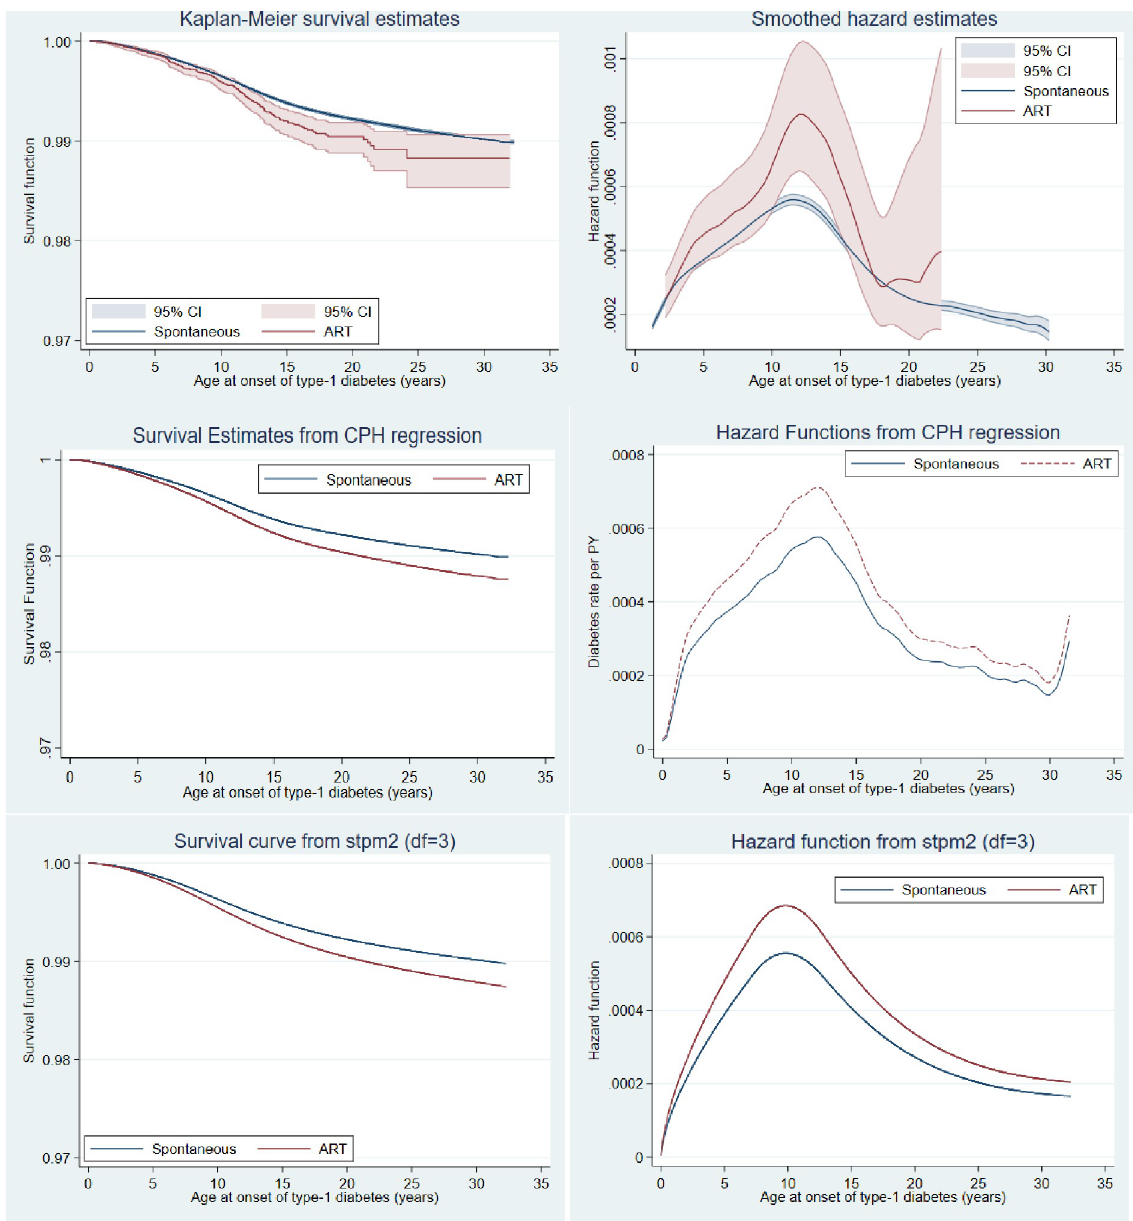
Fig 3. Comparison of hazard and survival functions under different survival regression